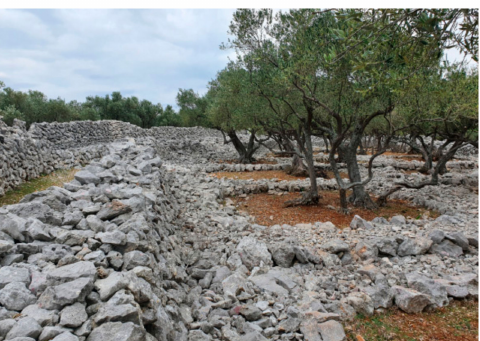
Figure 18. From left to right: a dry stone wall pathway, higher double wall ( gromaˇca ), lower dry stone walls ( barbakan ) (Tanja Kremeni´c, 2020).